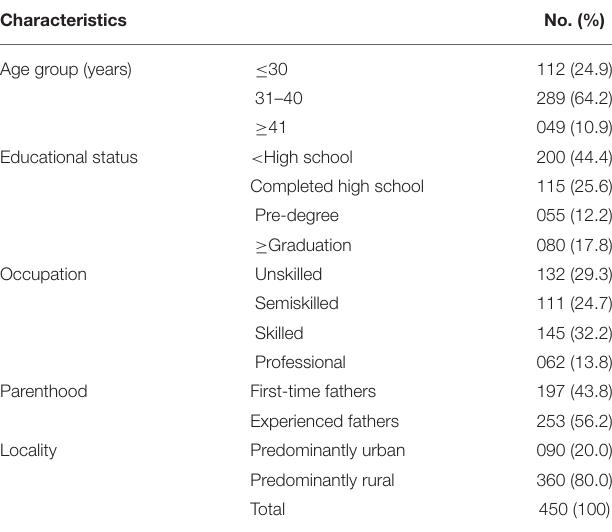
TABLE 2 | Knowledge and perceptions related to IYCF among the study participants ( N = 450).